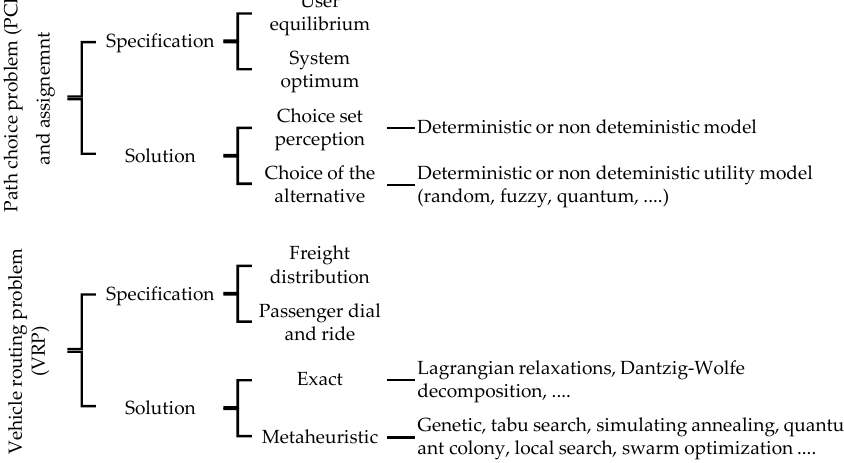
Figure 1. State of the art’s classification.